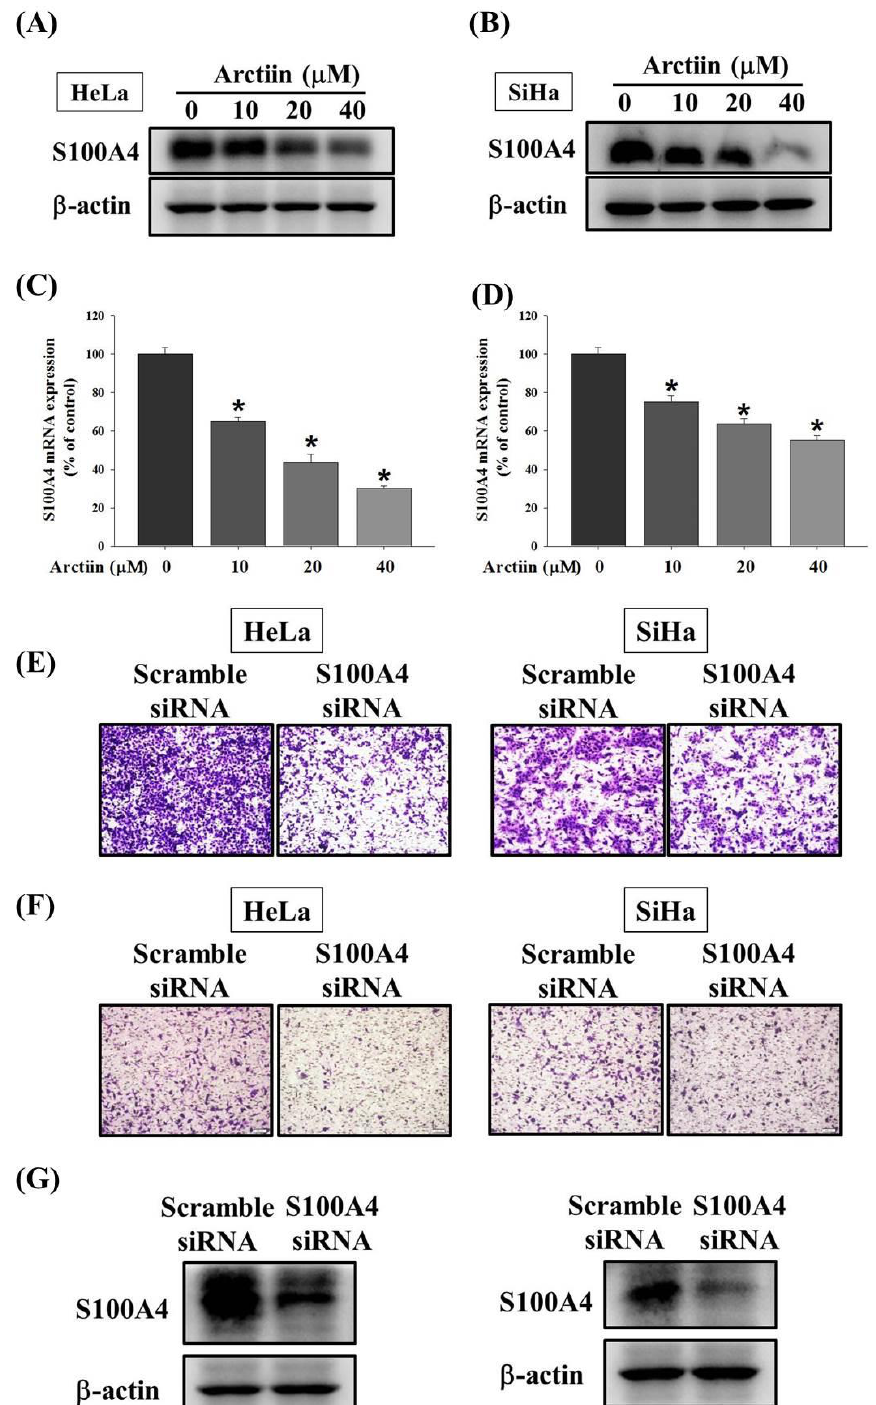
Figure 3. Effects of arctiin on the S100A4 protein expression and mRNA levels of HeLa and SiHa cells. After being treated with arctiin at a concentration of 0, 10, 20, and 40 μM for 24 h, the S100A4 protein and mRNA expression of HeLa ( A , C ) and SiHa ( B , D ) were measured by Western blotting assay and real time PCR assay, respectively. After silencing S100A4 in the HeLa cells and SiHa cells, ( E ) Boyden chamber assay, ( F ) Boyden chamber invasion assay, and ( G ) Western blot were used for analysis. The values represented the means ± SD of at least 3 independent experiments. * p < 0.05, compared with the group that was without arctiin treatment.